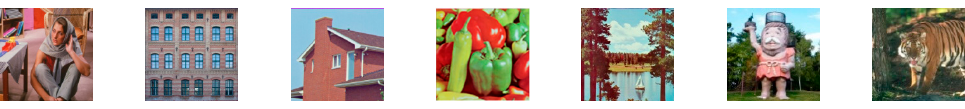
Figure 6. Ground truth of nine benchmark color images: Airplane, Baboon, Barbara, Façade, House, Peppers, Sailboat, Giant and Tiger (from left to right).